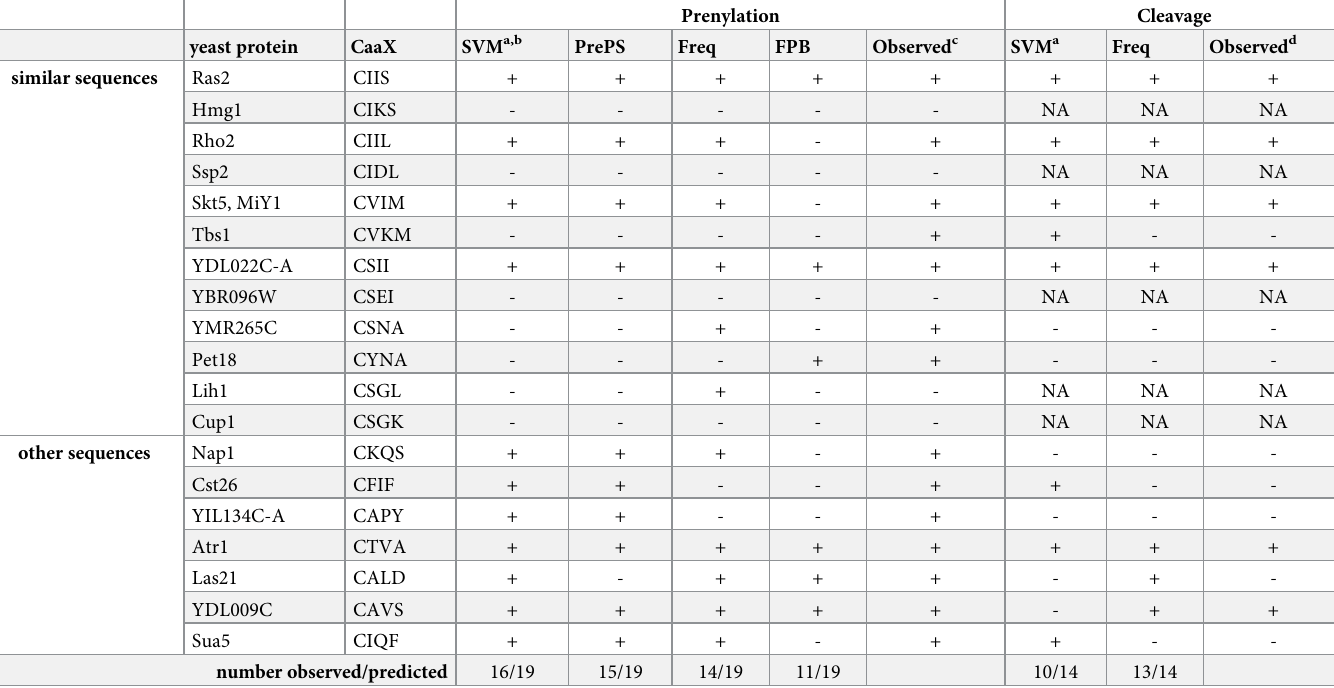
Table 3. Comparison of prenylation and cleavage prediction models with empirical